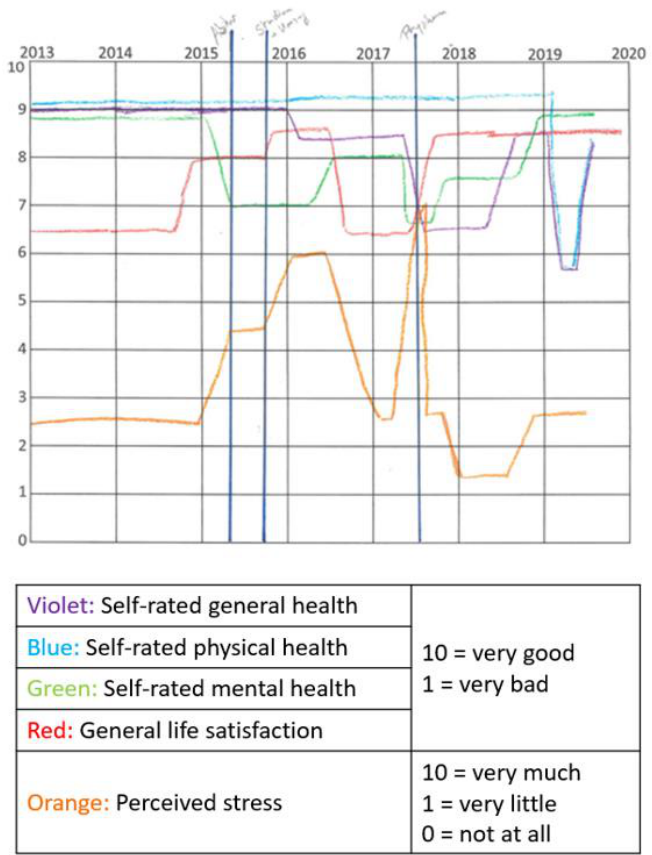
Figure 1. Example of a filled in mapping grid.